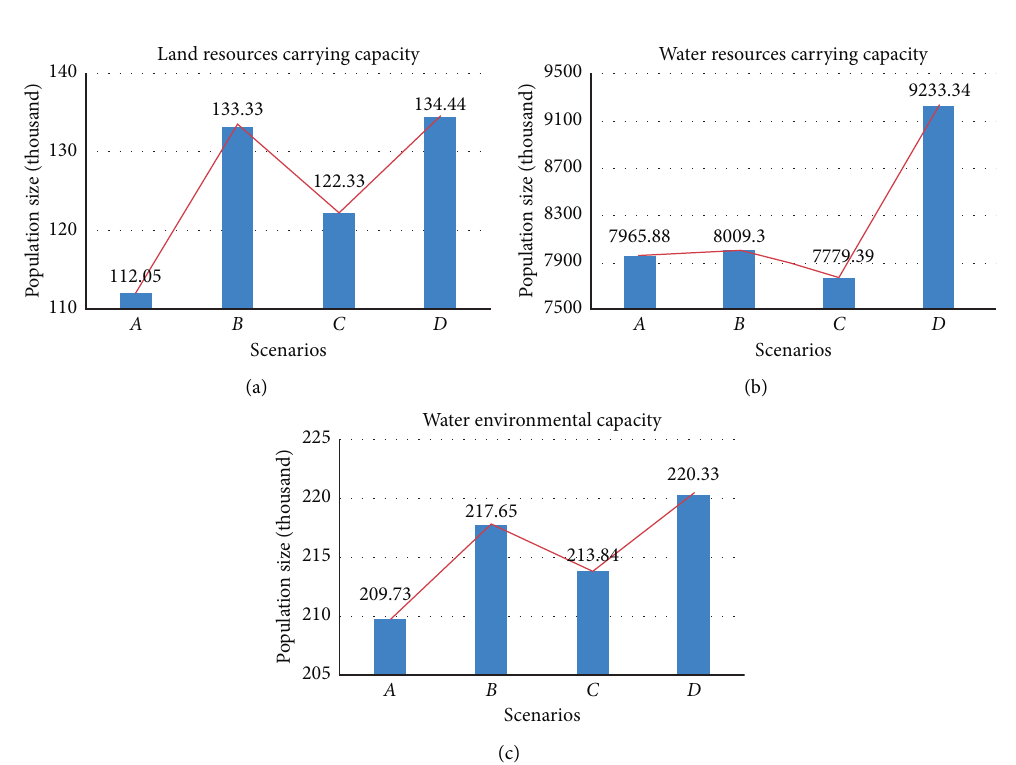
Figure 3: RECC of the different development scenarios in Jingjiang.